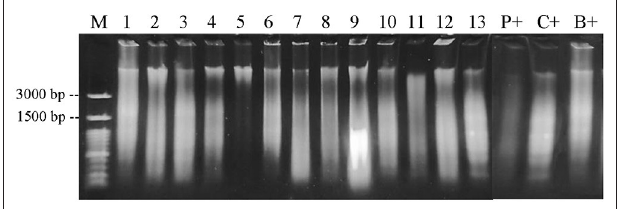
FIGURE 2 | Visualization of DNA isolated from meat and control positive meatball samples, electrophoresed on 0.8% agarose gel. (M) DNA marker 100 bp. (1) Indonesia native chicken; (2) layer chicken; (3) broiler chicken; (4) Bos indicus cattle; (5) Bos taurus cattle; (6) pork; (7) quail; (8) Manila duck; (9) duck; (10) sheep; (11) goat; (12) red tilapia; (13) catfish; (P + ) pork meatball; (C + ) chicken meatball; (B + ) beef meatball.